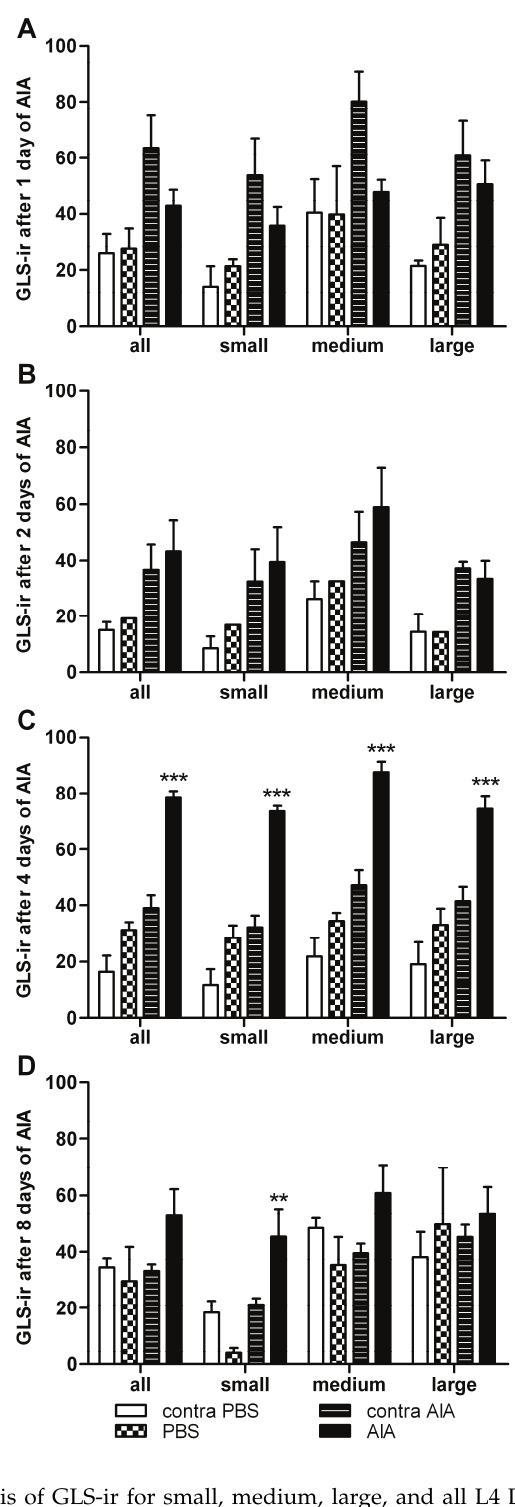
Figure 4. Image analysis of GLS-ir for small, medium, large, and all L4 DRG neurons. ( A , B ) No significant difference in GLS-ir occurred after one or two days of inflammation; ( C ) Elevation in GLS-ir occurred in all DRG neuronal sizes after four days of inflammation (*** p < 0.001; 121.4% overall increase); ( D ) GLS-ir elevation also occurred in small neurons after eight days of inflammation (** p < 0.01).